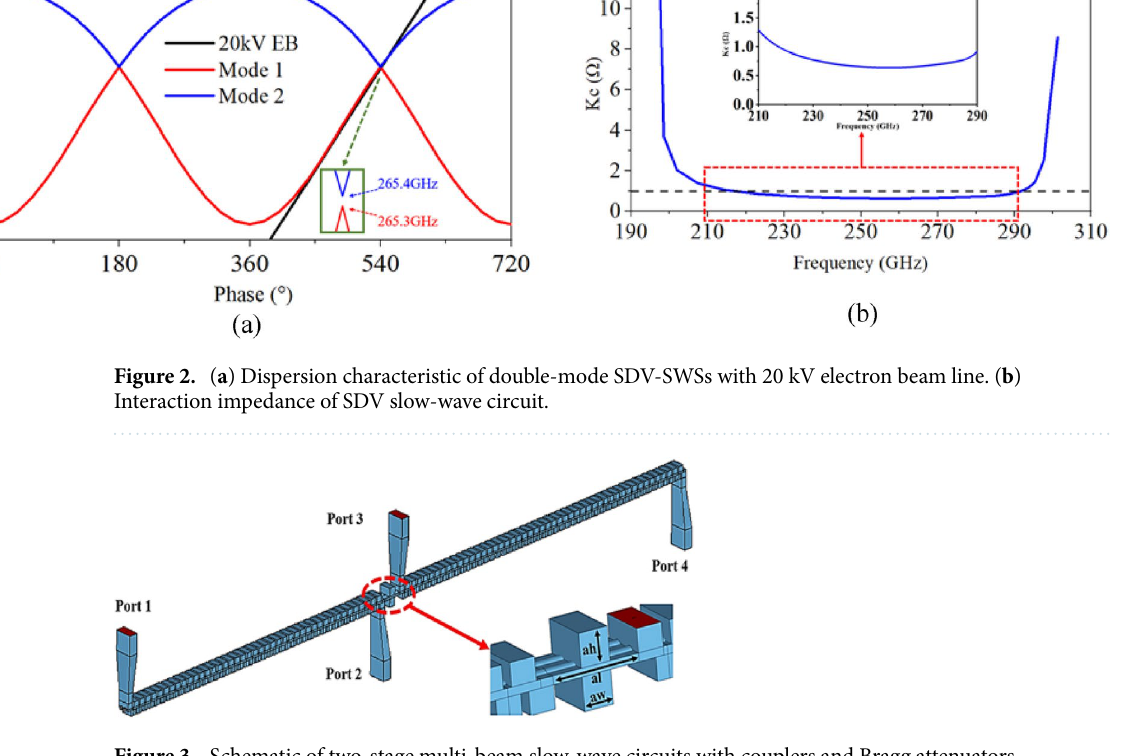
Figure 3. Schematic of two-stage multi-beam slow-wave circuits with couplers and Bragg